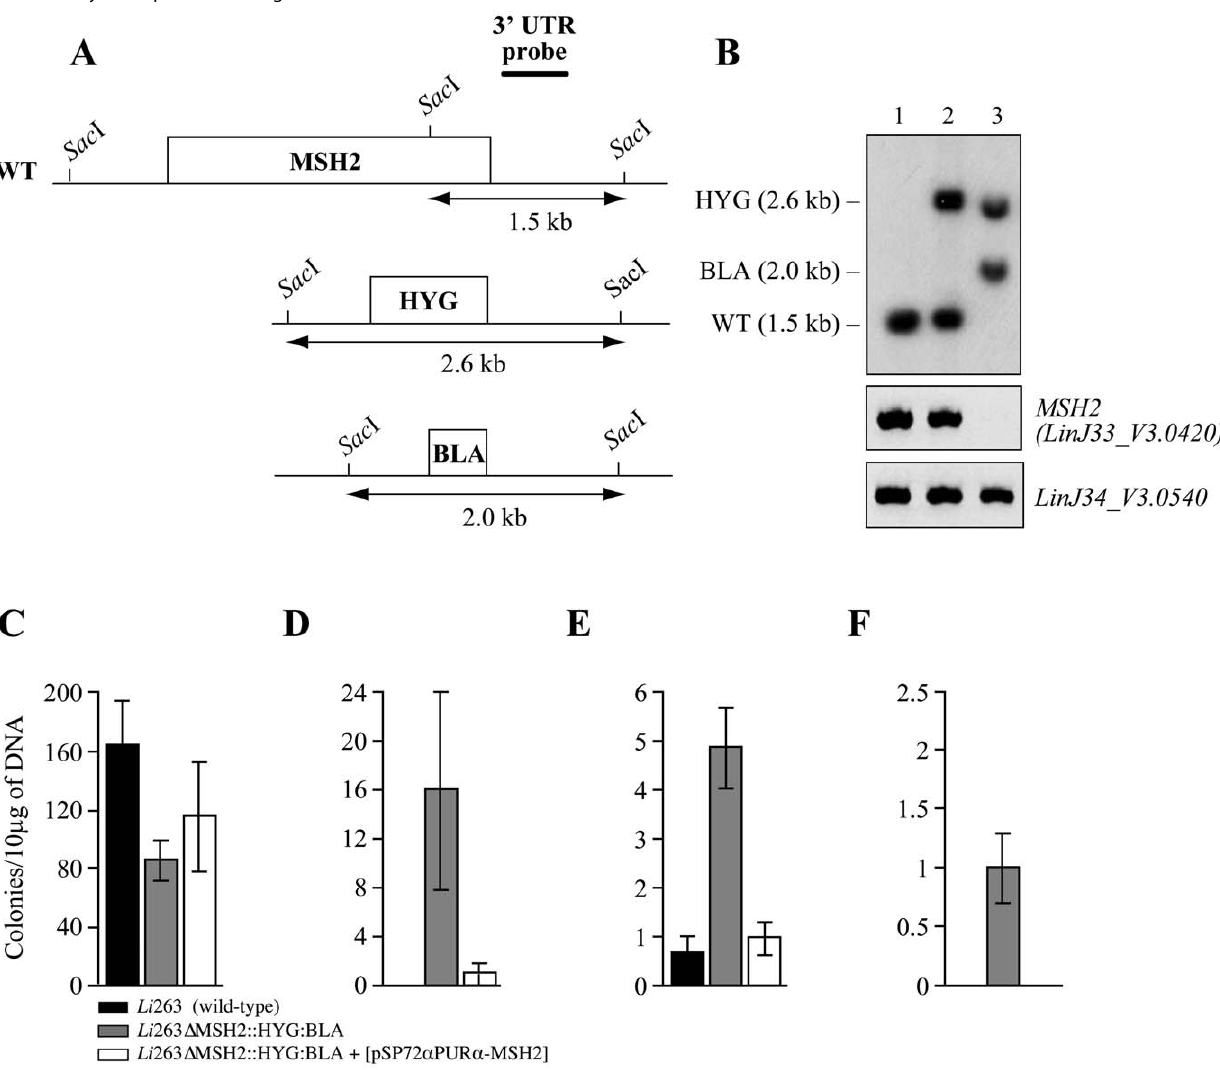
Figure 3. Generation of L.infantum hybrids. Genomic DNAs derived from L. major Friedlin NEO recombinants were electroporated into L. infantum . Chromosomes of putative hybrids were separated by pulsed-field gel electrophoresis. (A) L. infantum 263 and JPCM5 wild-type cells (lanes 1, 3) were transformed with gDNA derived from Lm D PK ::NEO/PK (LmjF30.1250) (lanes 2, 4). The hybridization of chromosome sized blots with probes derived from the NEO (left panel) or LmjF30.1255 (right panel) genes confirmed the proper integration of L. major DNA in L. infantum PK locus. (B) L. infantum JPCM5 and 263 WT cells (lanes 1, 3) were transfected with Lm D LmjF 01.0315 ::NEO/LmjF01.0315 gDNA (lanes 2, 4). The hybridization of chromosome sized blots with probes derived from the NEO (left panel) or LmjF01.0310 (right panel) genes confirmed the proper integration of L. major DNA in L. infantum. (C) Generation of hybrids into L. infantum 263 MSH2 null mutants. The hybridization of chromosome sized blots with probes specific for the NEO gene (upper panel) confirmed the proper integration of L. major -derived DNA at the level of targeted chromosomes in L. infantum . Hybridizing the same blots with a probe specific for MSH2 (middle panel) confirmed the MSH2 -null mutant status of the L. infantum recipients while PTR1 hybridization served as a loading control. L. infantum 263 wild-type parasites transfected with gDNA derived from L. major Lm D LRP ::NEO/NEO (lane 1); L. infantum Li263 D MSH2 ::HYG/BLA transfected with gDNA derived from L. major Lm D LRP ::NEO/NEO (lanes 2 and 3) or L. major Lm D LmjF05.0610::NEO/LmjF05.0610 (lane 4). Schematic map of the genomic region encompassing the PK (D), the LmjF01.0315/LinJ01_V3.0315 (E), and LRP (F) genes of L. infantum JPCM5 (black boxes) or L. major Friedlin (white boxes) and hybrid regions with one allele derived from L. major and one allele from L. infantum (grey boxes) as determined by multilocus PCR sequencing (Tables S6, S7, S8, S9, 10).